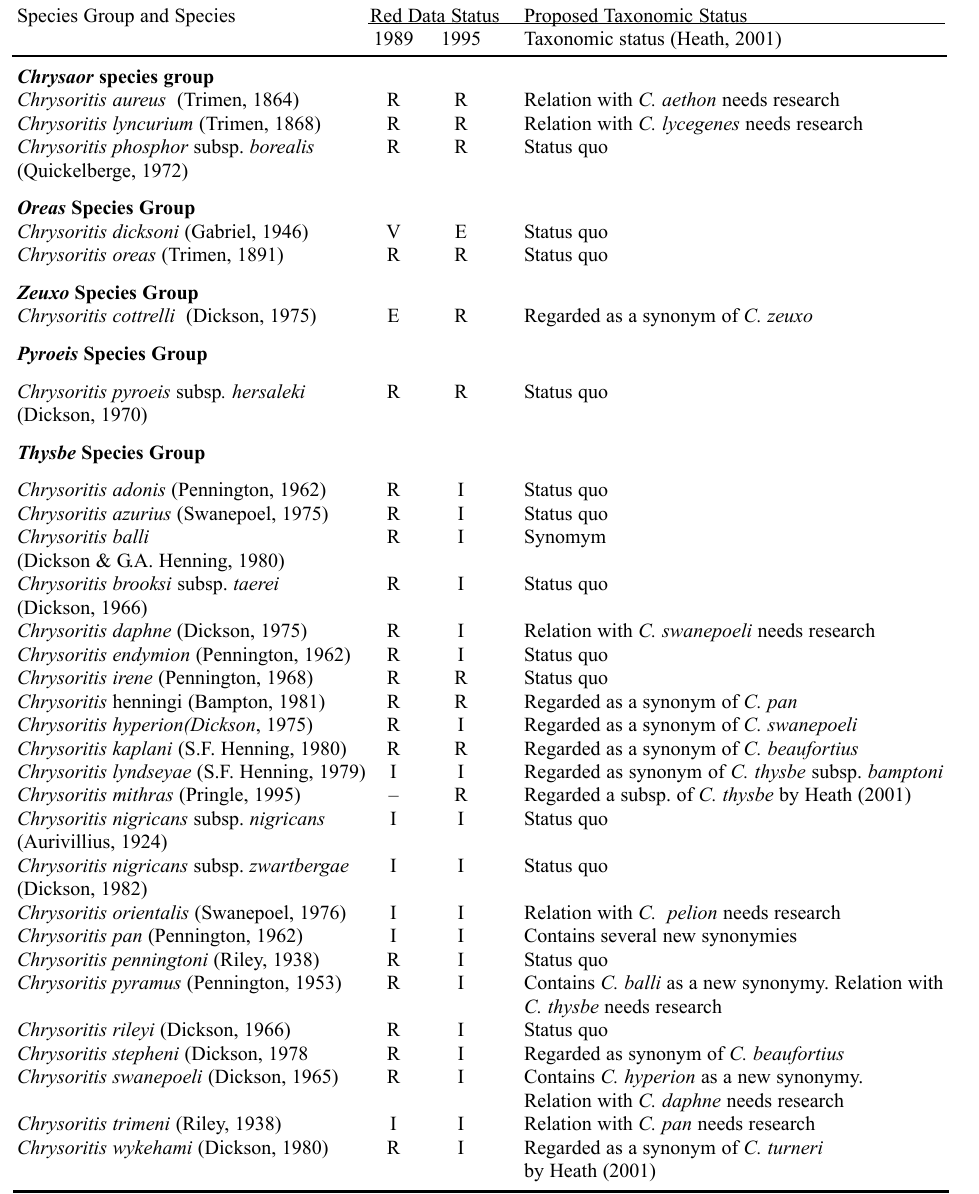
Table 2 A summary of the red data book status of Chrysoritis species in the past. Literature sources: S.F. &